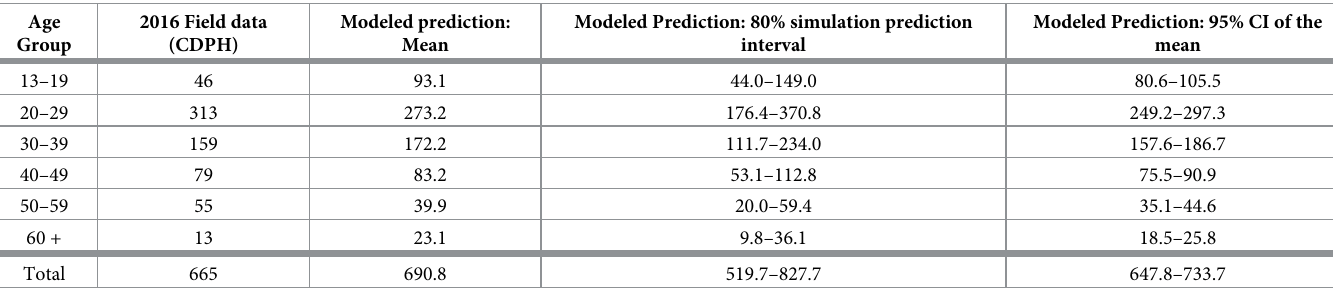
Table 3. Observed and predicted annual incidence cases by age.